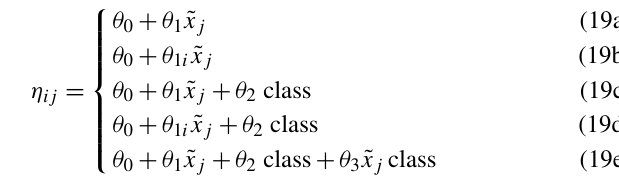
Figure 9. Comparison between observed and simulated flow depths at damaged building for an S8 ratio of 1.2; a confidence interval is set at 1m flow